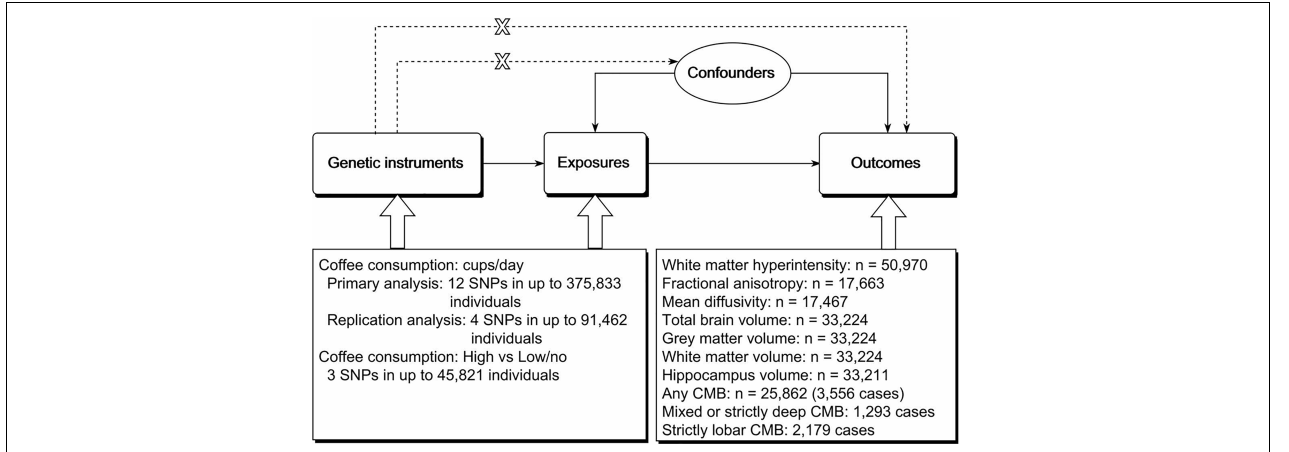
FIGURE 1 | Schematic representation of the study design. The three assumptions of the two-sample MR study are as follows: genetic instrument is associated with exposure; genetic instrument is not associated with confounders; and genetic instrument does not affect outcome via pathways other than the exposure of interest. MR, Mendelian randomization; SNP, single nucleotide polymorphism; CMB, cerebral